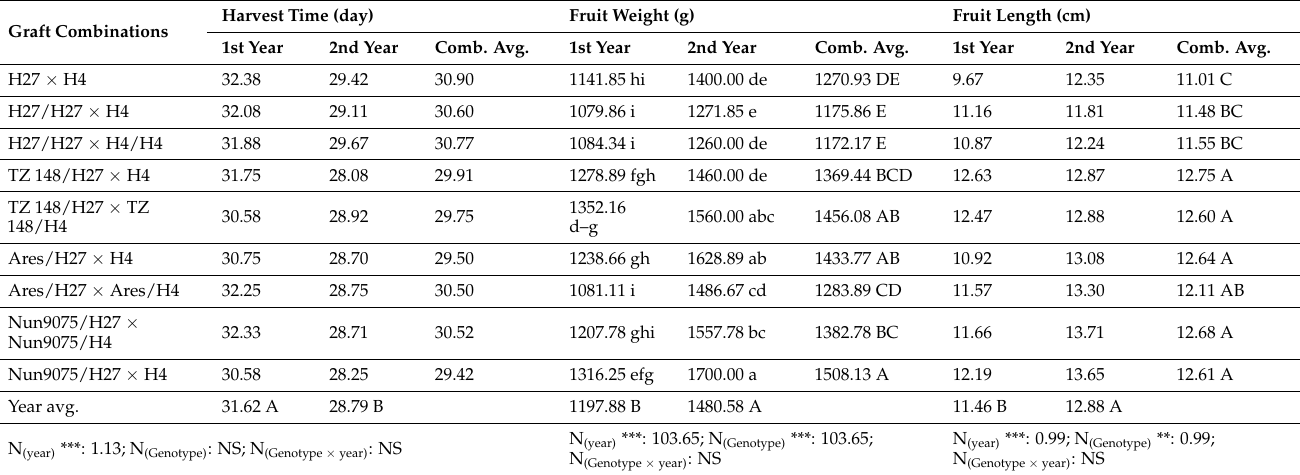
Table 3. Harvest time, Fruit weight and Fruit length of different graft combinations in both years.